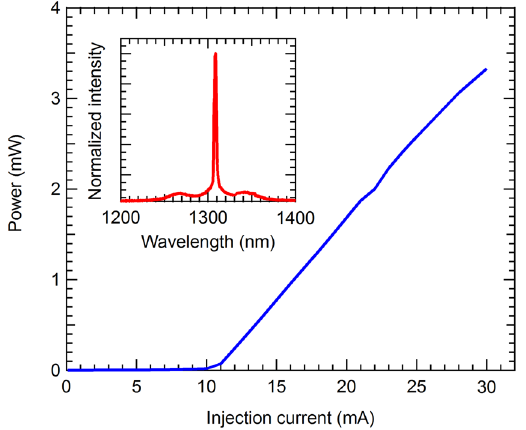
Figure 2. Input-output characteristics of the laser diode used in this study. The inset shows the lasing spectrum of the laser with an input current of 20 mA.